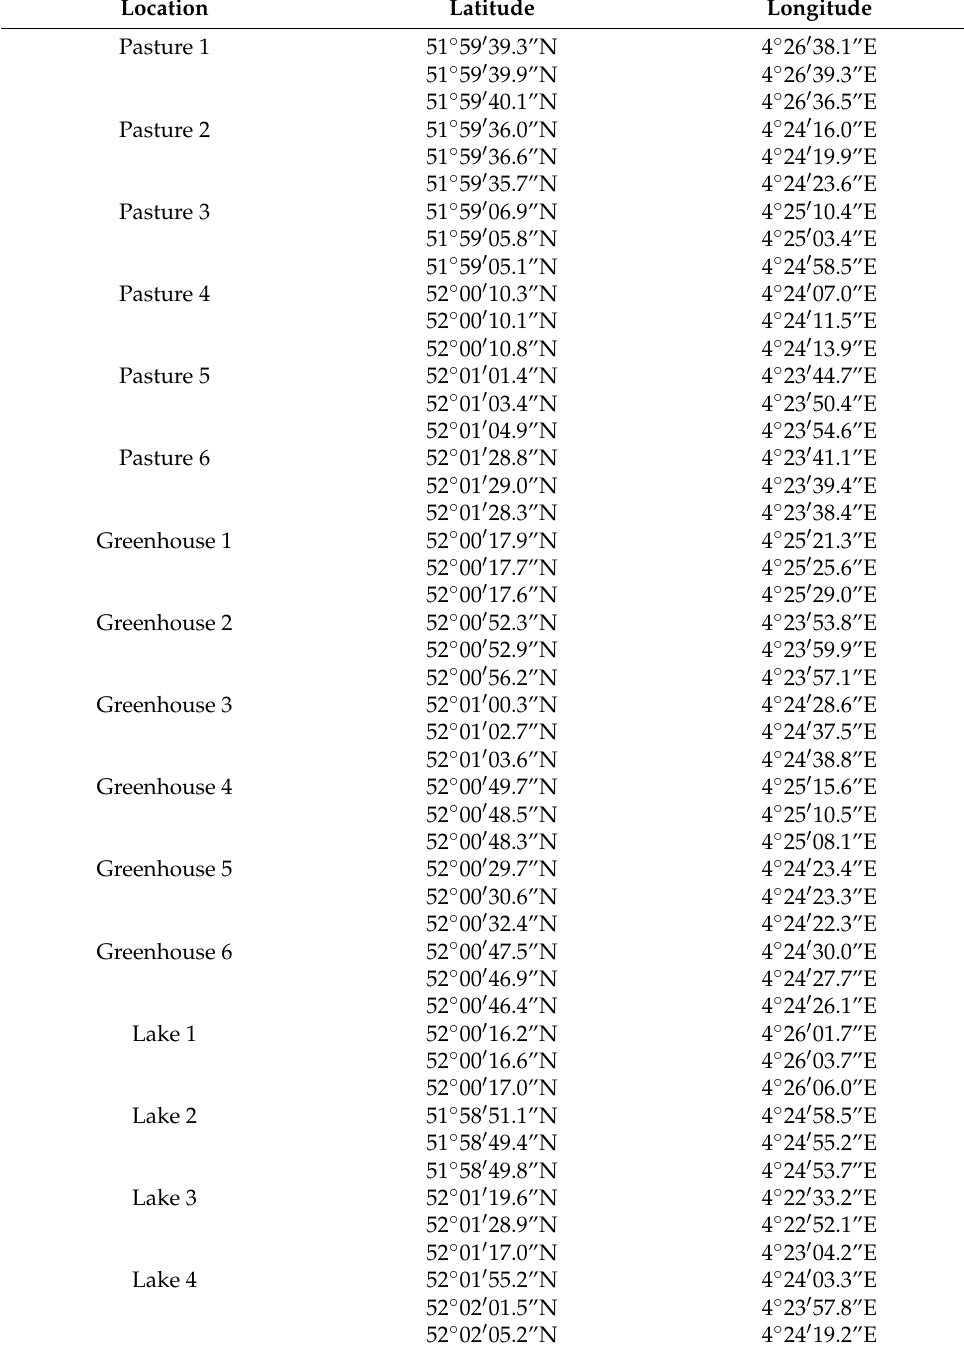
Table A1. Latitudes and longitudes of all sampling